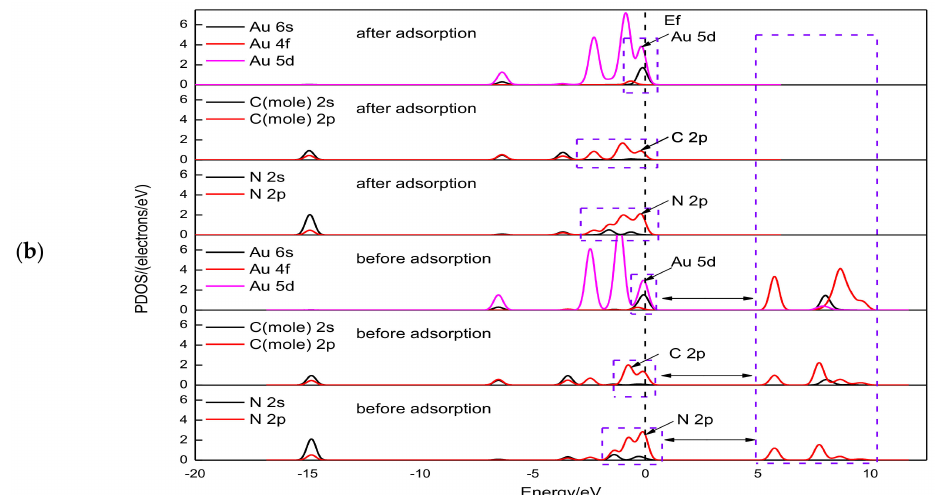
Figure 5. Partial density of state (PDOS) of each atom in graphite (0001) and [Au(CN) 2 ] − before and after adsorption. ( a ) PDOS of graphite (0001) before and after adsorption. ( b ) PDOS of each atom in [Au(CN) 2 ] − before and after adsorption.